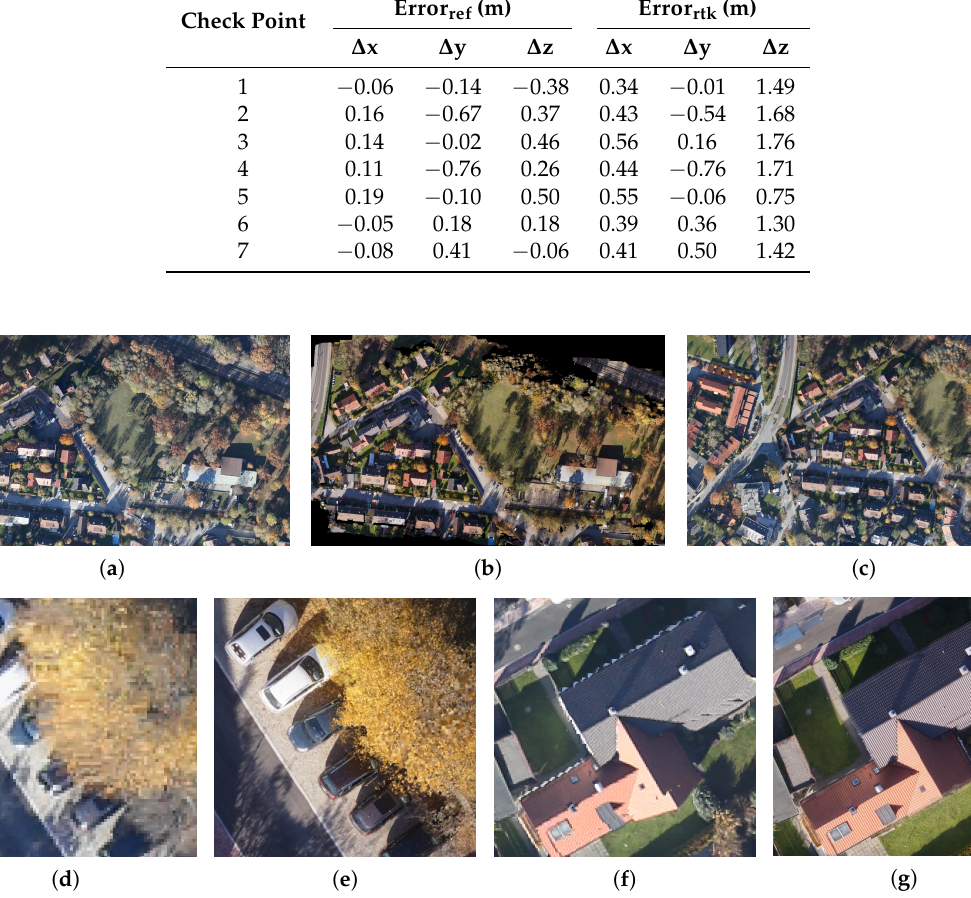
Figure 12. Comparison of ( a ) the aerial orthophoto with 20cm GSD and ( b ) the UAV orthophoto with 2cm GSD of the Eichenau dataset; ( c ) 50% transparent overlap of both orthophotos; ( d , e ) compare cars and ( f , g ) show a roof on the aerial and UAV orthophoto,